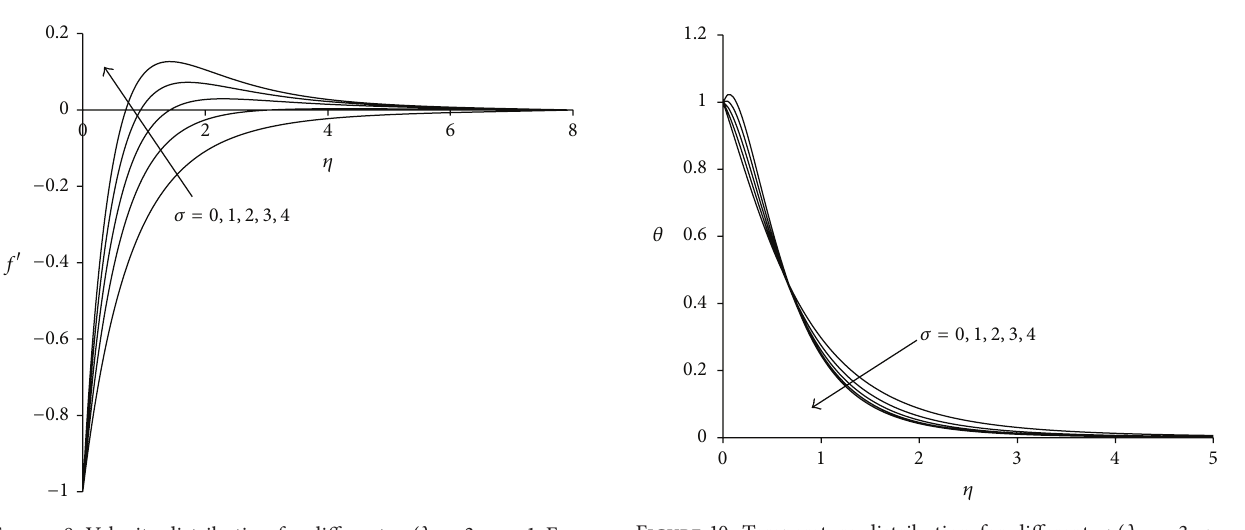
Figure 8: Velocity distribution for different 𝜎 (𝜆 = 3,𝜏 = 1, Ec = 0.75) .